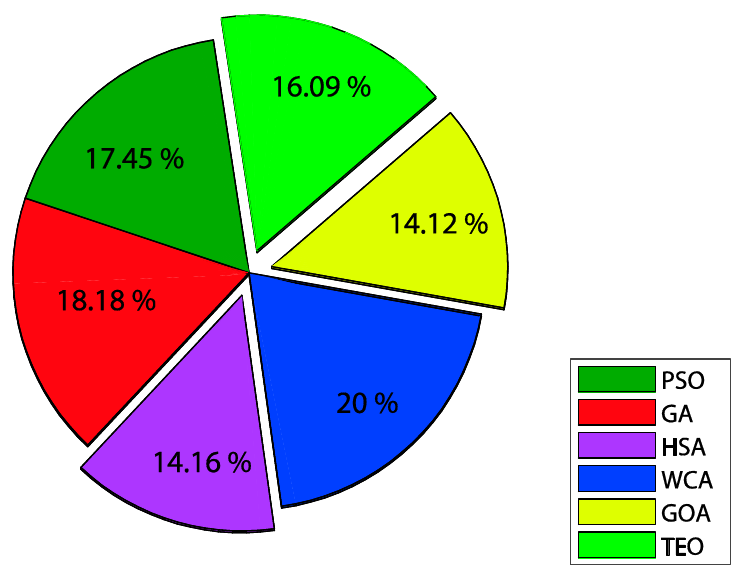
Figure 17. Average elapsed time over all criteria for the introduced algorithms.